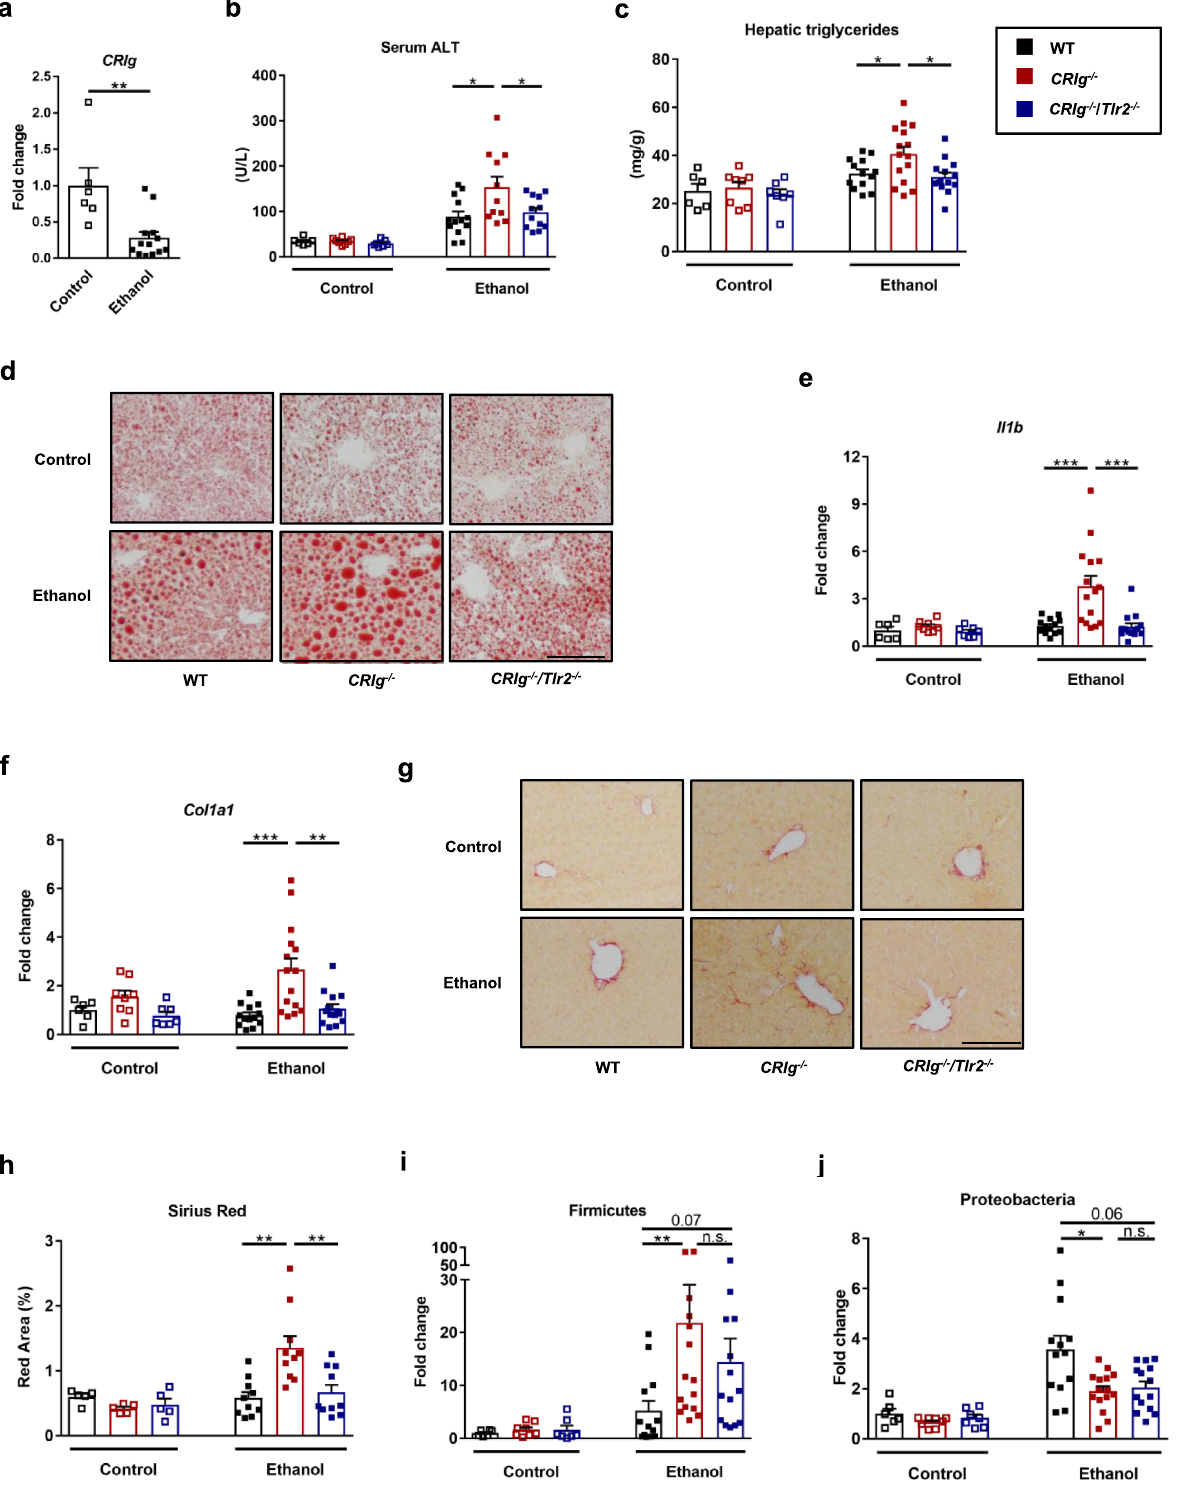
Fig. 2 De fi ciency of CRIg causes progression of ethanol-induced liver disease in mice. Wild-type (WT), CRIg − / − , and CRIg − / − / Tlr2 − / − mice were fed the Lieber DeCarli ethanol diet for 8 weeks. a Hepatic level of mRNA encoding CRIg in WT mice. b Serum levels of ALT. c Hepatic triglyceride content. d Representative oil red O-stained liver sections. e and f Hepatic levels of Il1b and Col1a1 mRNAs. g Representative sirius red-stained liver sections. h Quanti fi cation of the sirius red-stained liver sections. i and j Hepatic DNA levels of Firmicutes and Proteobacteria, normalized to total amount of bacteria using universal 16S primers. Scale bar = 100 μ m. Results are expressed as mean ± s.e.m. ( a – c , e , f , h – j ). P values among groups of mice fed with control diet or ethanol diet are determined by two-sided Student t -test ( a ) or one-way ANOVA with Tukey´s post-hoc test ( b , c , e , f, h – j ). * P < 0.05, ** P < 0.01, *** P < 0.001.